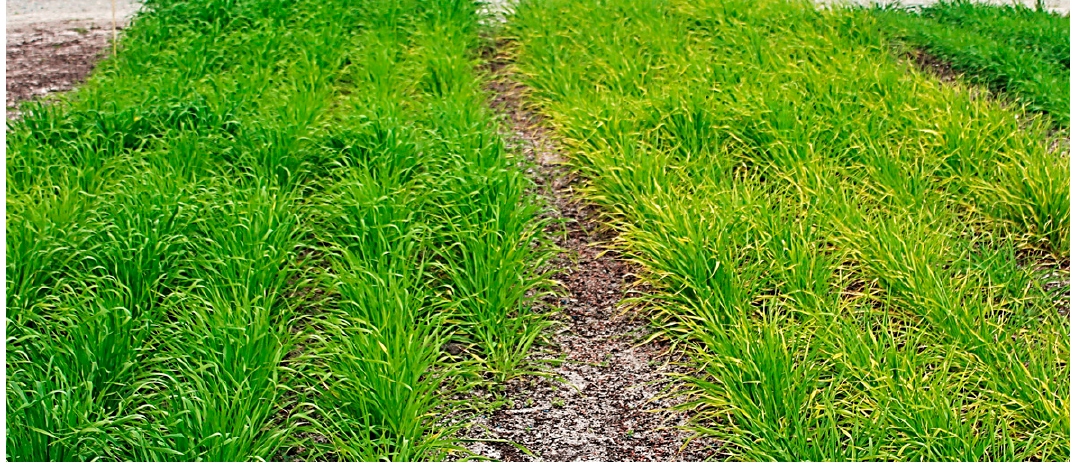
Figure 1. Field-grown barley Pallas 22 ( mlo-5 ) plants displaying chlorosis and senescence on the right-hand side, compared to a wild-type Mlo line Pallas 18 on the left-hand side.